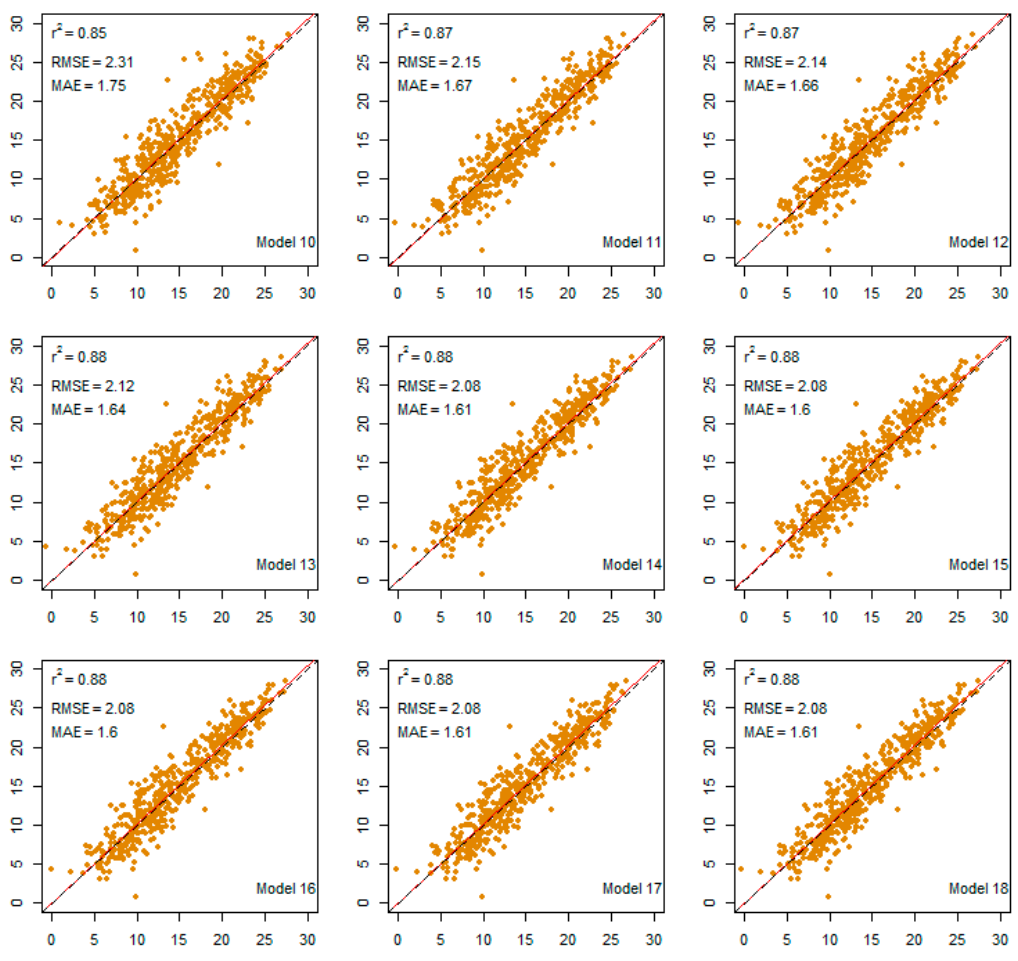
Figure 5. The relationship between T a observed (y-axis) and T a estimated (x-axis) using Models 10–18. The dashed black line indicates the 1:1 line. The solid red line shows the regression line.